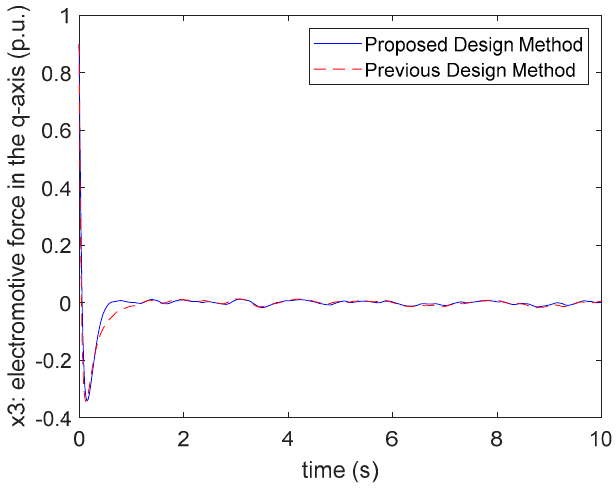
Figure 15. The comparison of state ( )